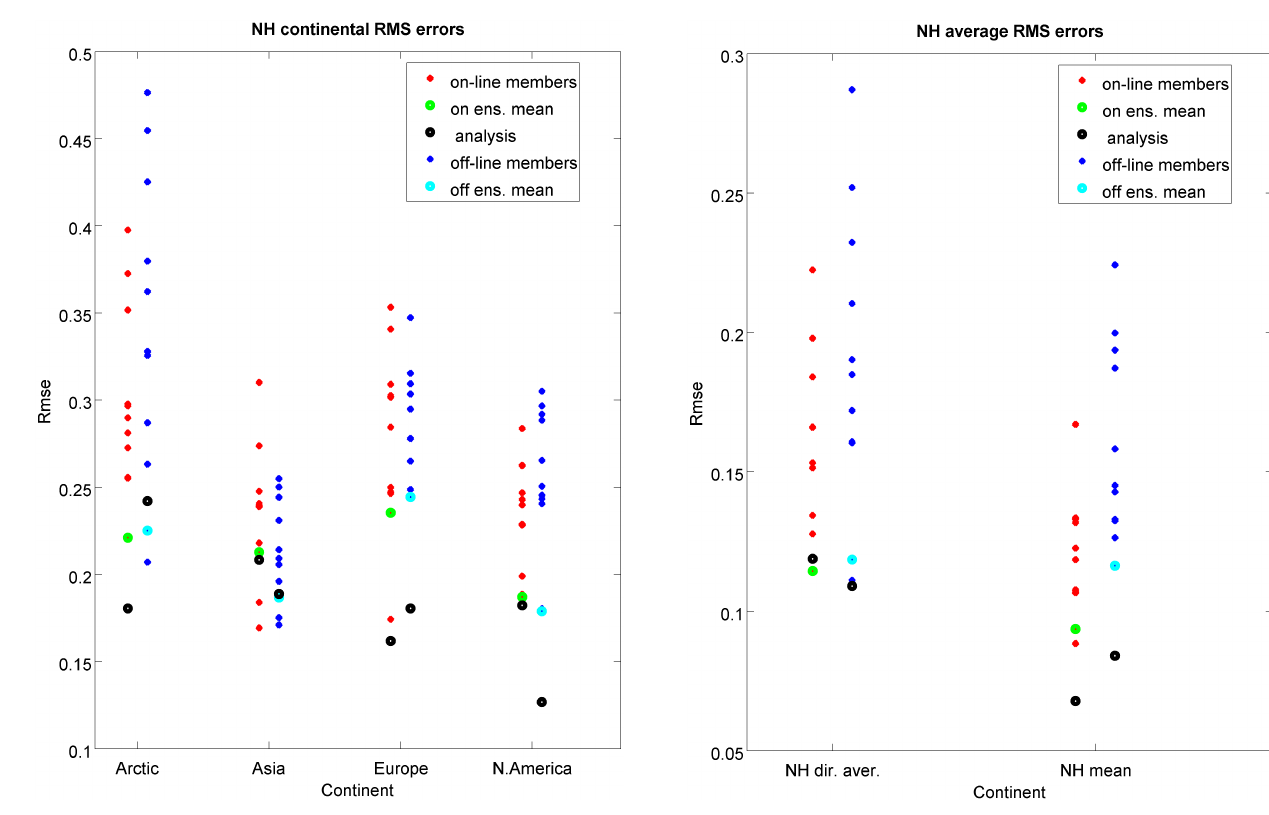
Figure 5. The rms errors for the direct average and the mean of the Northern Hemisphere for the 17th century, for the on-line (red dots) and off-line (blue dots) ensemble members, the on-line (green dots) and off-line (cyan dots) ensemble means, and the two analyses (black